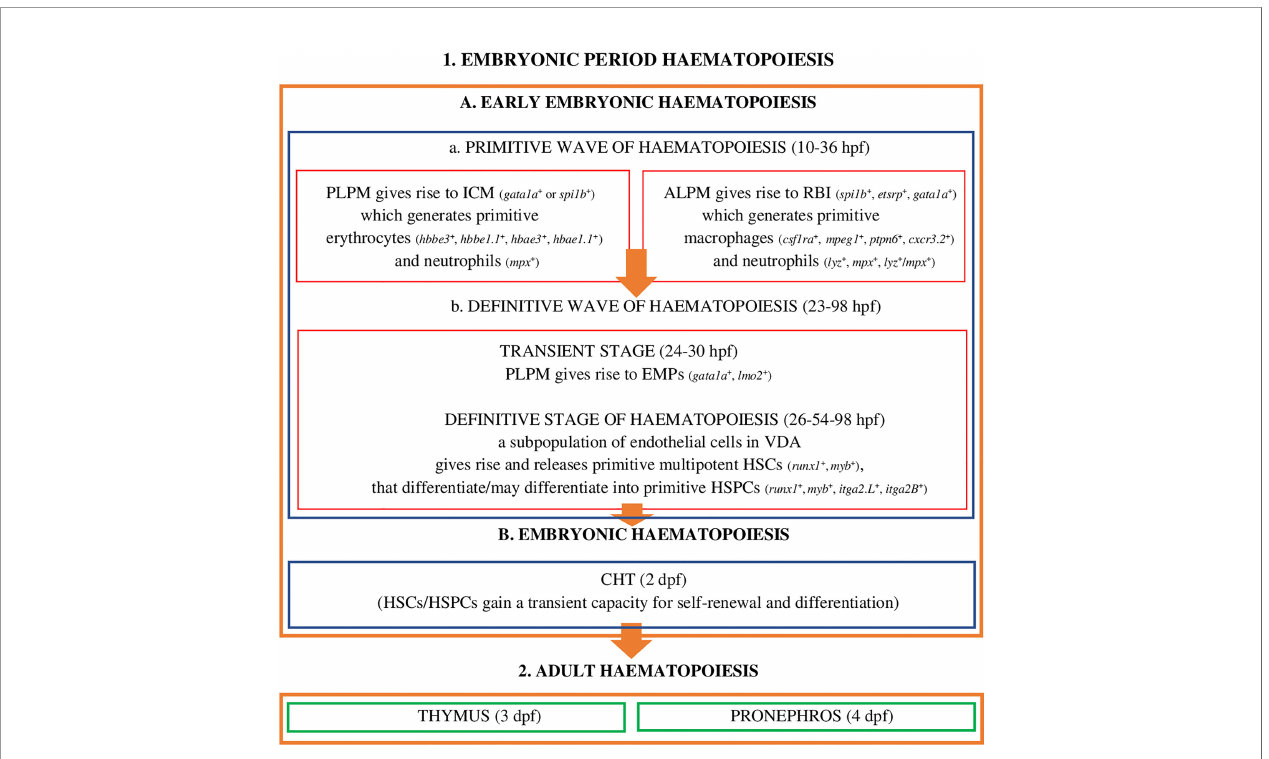
FIGURE 1 | Embryonic period haematopoiesis and adult haematopoiesis in zebra fi sh (D. rerio) (references in the main text). Explanatory notes for part (A, B) : PLPM, posterior lateral-plane mesoderm; ALPM, anterior lateral-plane mesoderm; ICM, intermediate cell mass; RBI, rostral blood islands; VDA, ventral wall of the dorsal aorta; CHT, caudal hematopoietic tissue; hpf, hours post fertilization; dpf, days after fertilization; spi1b, Spi-1 proto-oncogene b; etsrp, ETS1-related protein; gata1a, GATA binding protein 1a; hbbe3, haemoglobin beta embryonic-3, hbbe1.1, haemoglobin beta embryonic-1.1; hbae3, haemoglobin alpha embryonic-3, hbae1.1, haemoglobin alpha embryonic-1.1, lyz, lysozyme C, mpx, myeloid-speci fi c peroxidase, lzm/mpx, double-positive neutrophils stain strongly with Sudan black; lmo2, LIM domain only 2; runx1, RUNX family transciption factor 1; myb, MYB proto-oncogene, transcription factor; itga2.L, integrin subunit alpha 2 L homeolog (itga2-A); itga2B, integrin subunit alpha 2 B